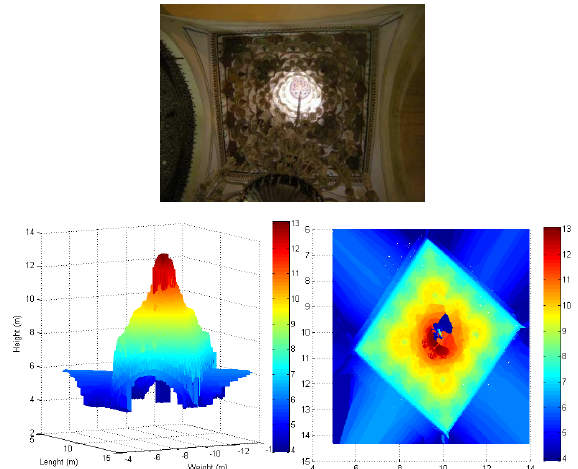
Figure 14. Digital elevation model of dome of Silver Sill (units are